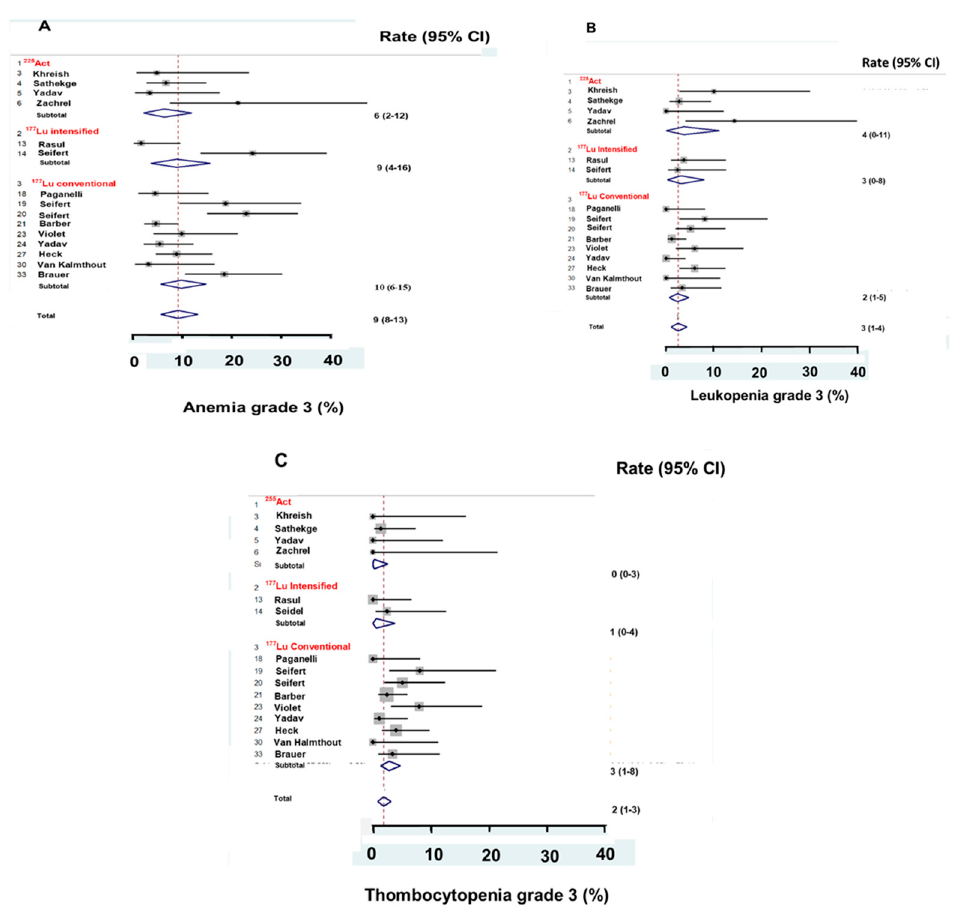
Figure 5. 225 Actinium PRLT and intensified and conventional schedule of 177 Lu PRLT gave similar hematologic adverse e ff ects grade 3. More patients had anemia grade 3 ( A ) than leucopenia grade 3 ( B ) and thrombocytopenia grade 3 ( C